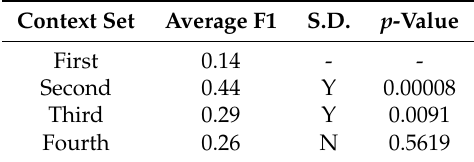
Table 8. Zeus Dataset—Training Context Combinations.